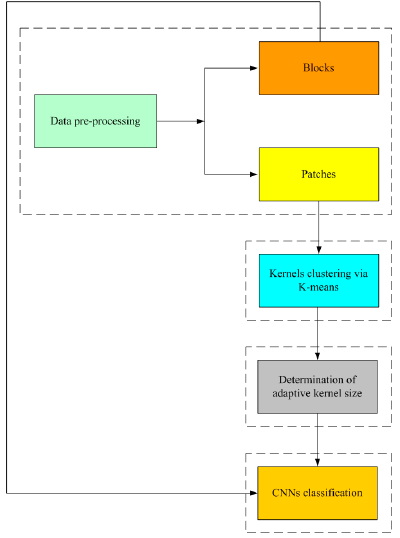
Figure 1. The flow chart of our proposed method.